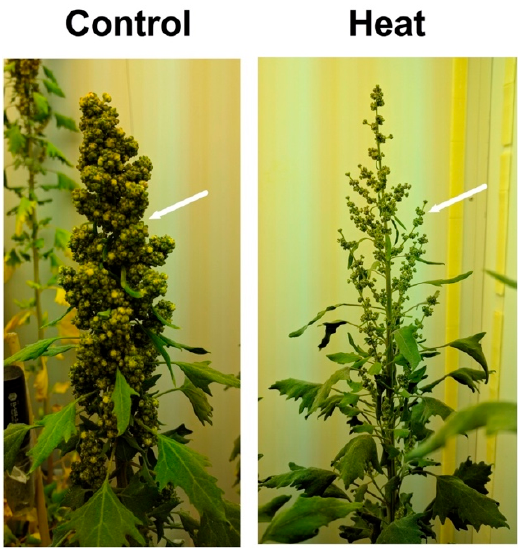
Figure 4. Impact of high temperature on the length of the secondary axis from the quinoa inflorescence. Plant grown under control conditions 22/16 °C ( left ) and high temperature 40/24 °C ( right ).